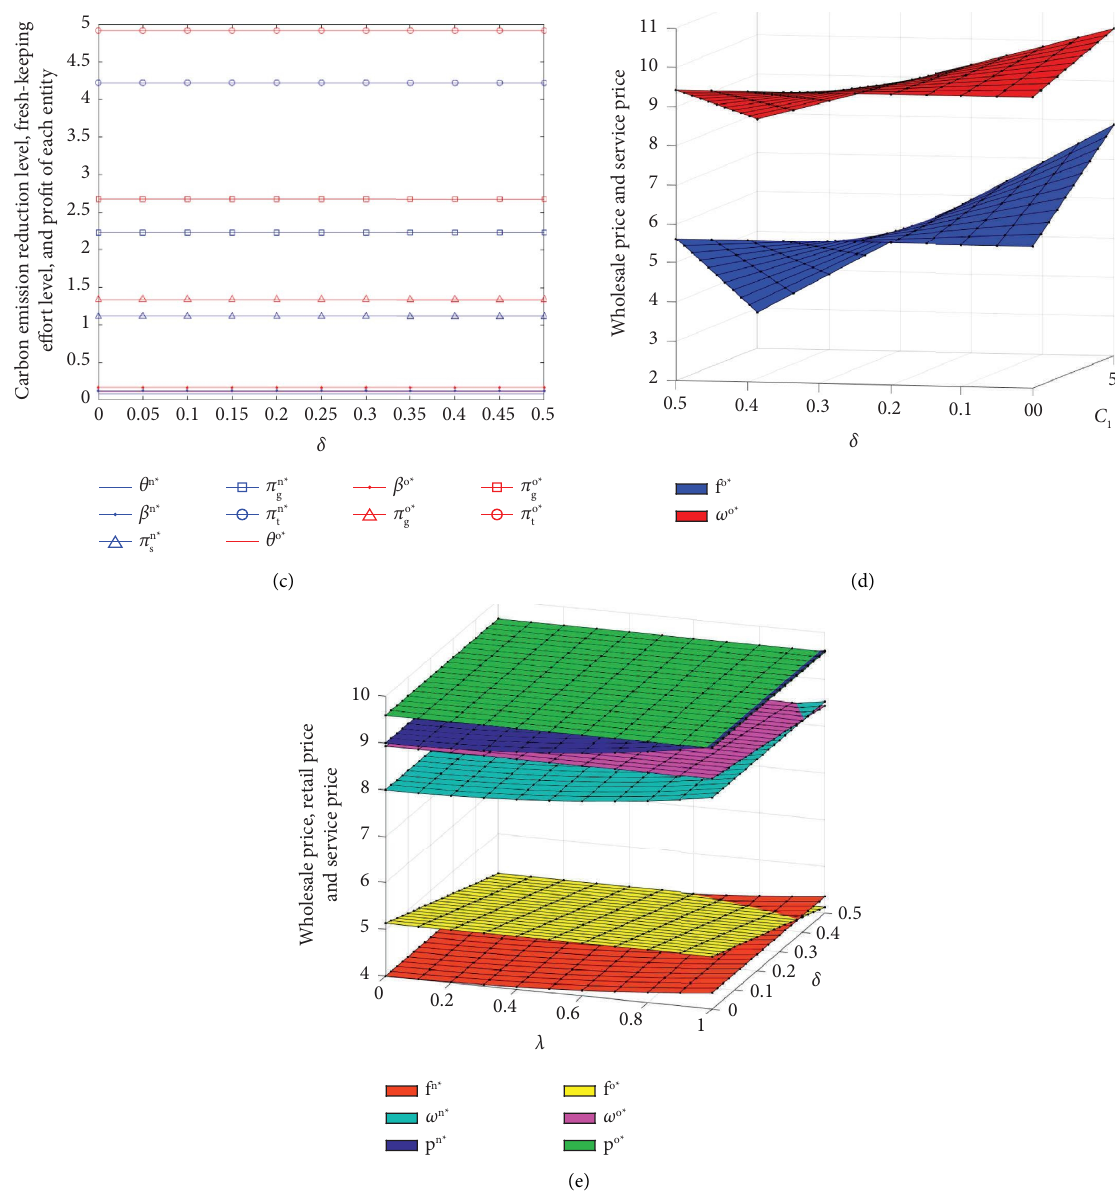
Figure 3: Efects of λ , c , and δ on supply chain system decisions and 1